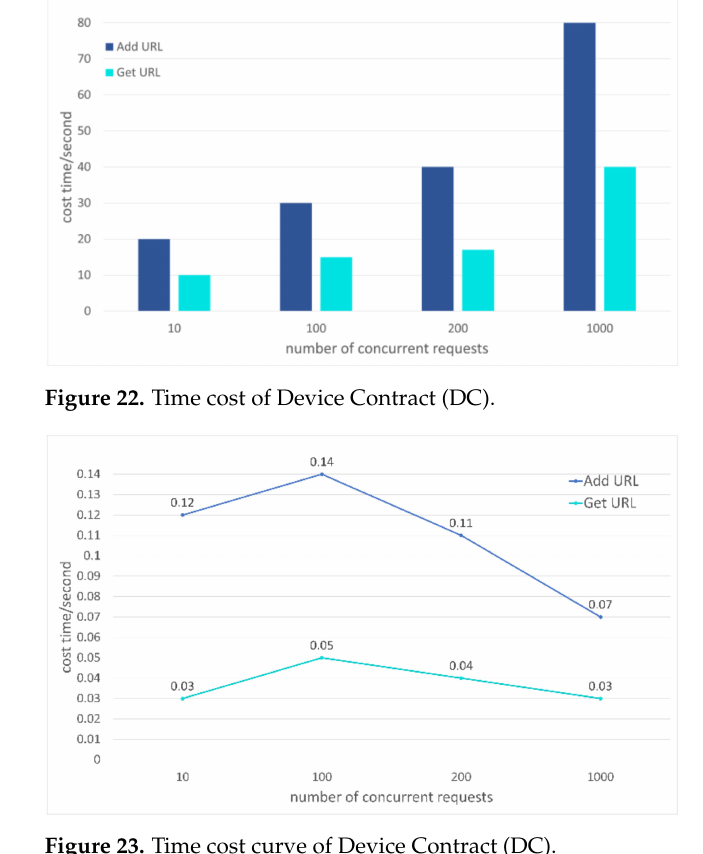
Figure 23. Time cost curve of Device Contract